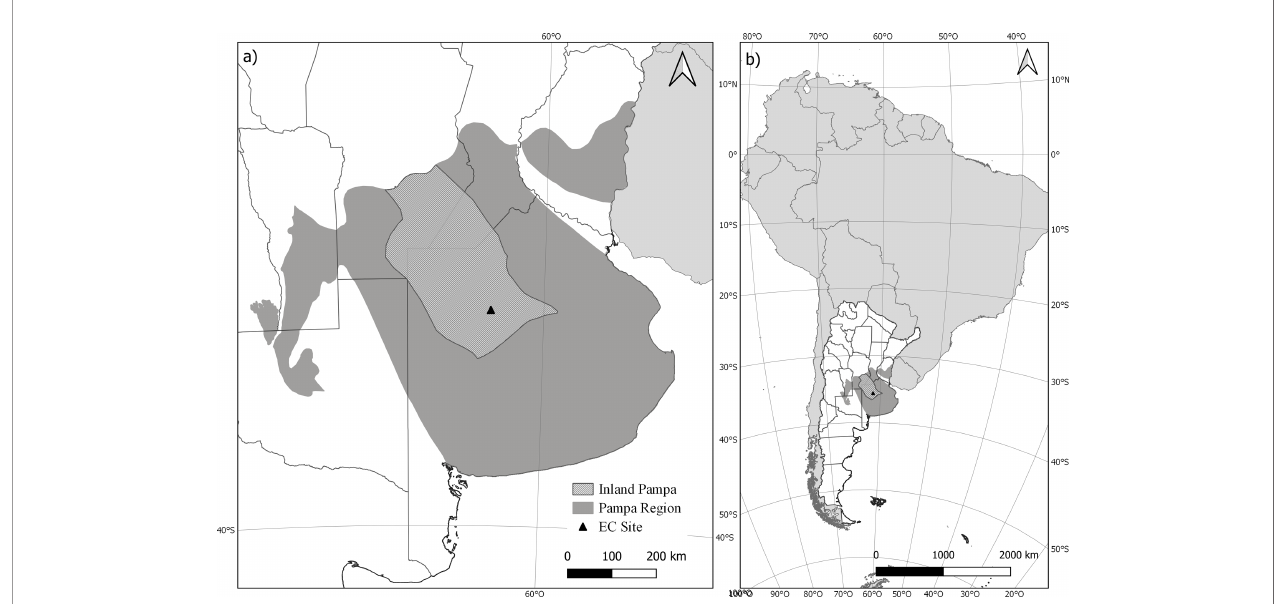
FIGURE 1 | Location of the study area. (A) Inland Pampa within the Pampa Region and location of the EC site in Carlos Casares. (B) Study region situated in South America. The extent of the Pampas region and the Inland Pampa was obtained from